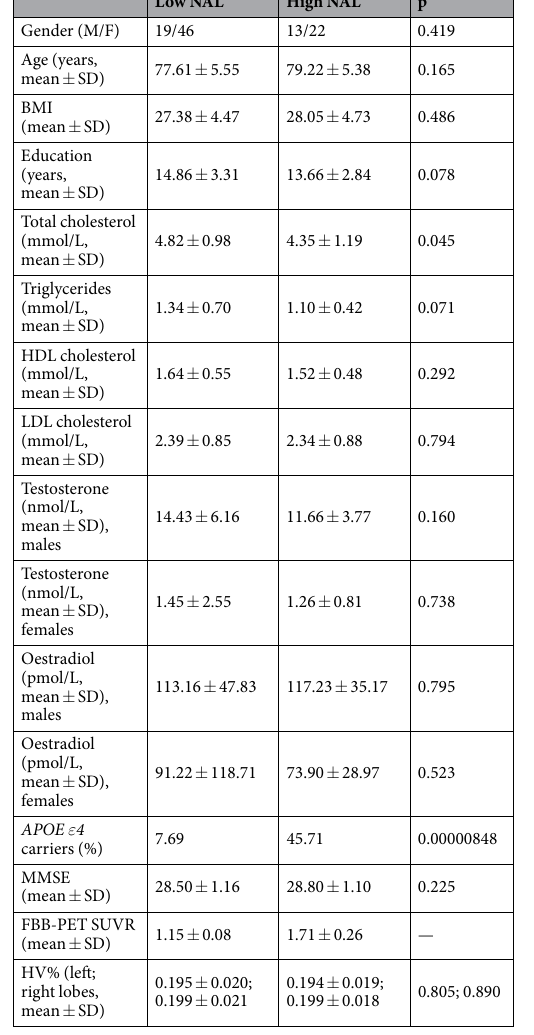
Table 1. Characteristics of study participants. Baseline characteristics including gender, age, body mass index (BMI), education, serum cholesterol, hormone levels, APOE ε 4 status, mini mental state examination (MMSE) scores, neocortical amyloid load (NAL) represented by the standard uptake value ratio (SUVR) of the ligand 18 F-Florbetaben (FBB) in the neocortical region normalised with that in the cerebellum and hippocampal volume (HV) normalised by the intracranial volume, have been compared between study participants with low NAL (SUVR < 1.35) and high NAL (SUVR ≥ 1.35). Chi-square test or linear models were employed as appropriate. HDL: high density lipoprotein, LDL: low density